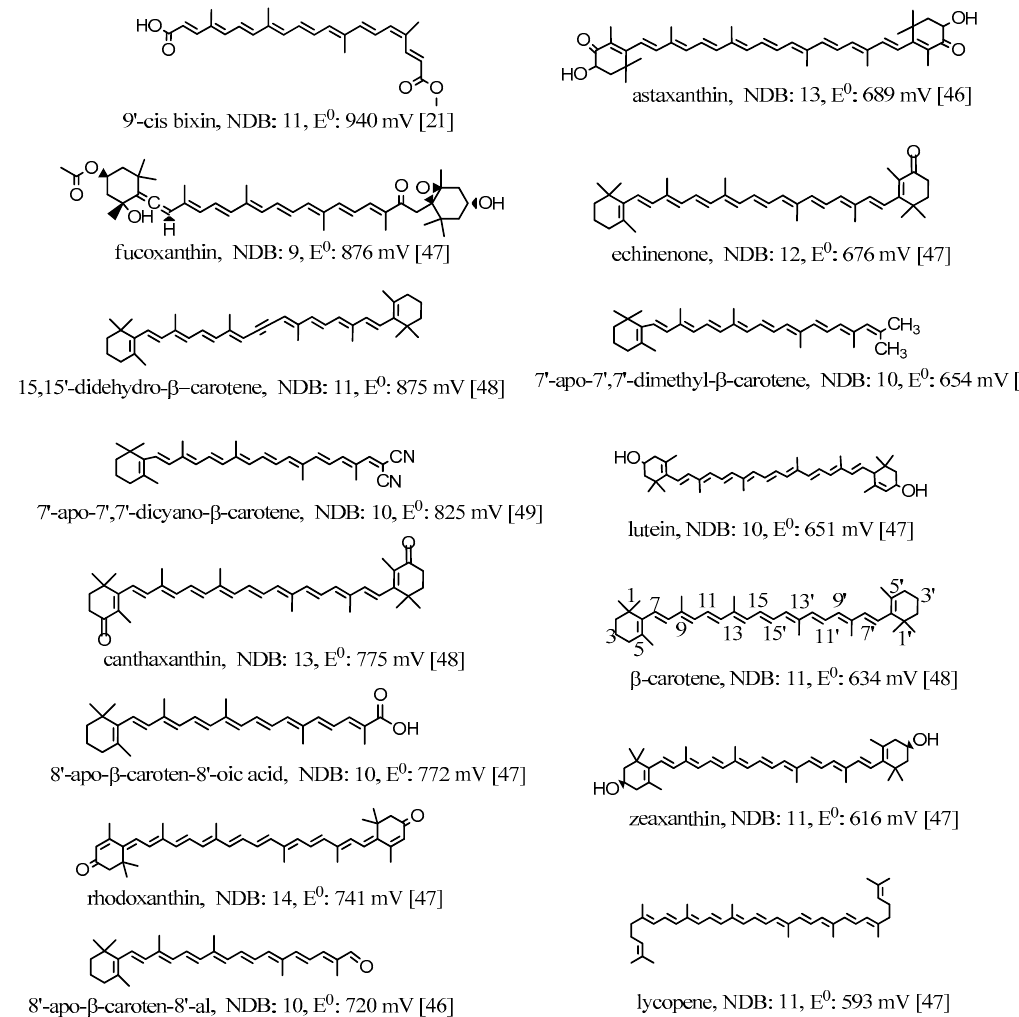
Figure 3. Structures, number of double bonds (NDB) and first oxidation potentials (vs. SCE) of selected carotenoids. The oxidation potentials were measured in CH 2 Cl 2 by the method of cyclic voltammetry (CV) with measurement error ± 10 mV. The reference electrode used in the measurements was saturated calomel electrode (SCE). Calibration with ferrocene gave the potentials corrected to SCE [46,48]. 86 mV was added to the potentials reported in Ref. [47] to correct for the absence of ferrocene calibration. This addition was shown to be needed in the examples given in Ref. [46]. The carbon atoms are numbered for β -carotene.